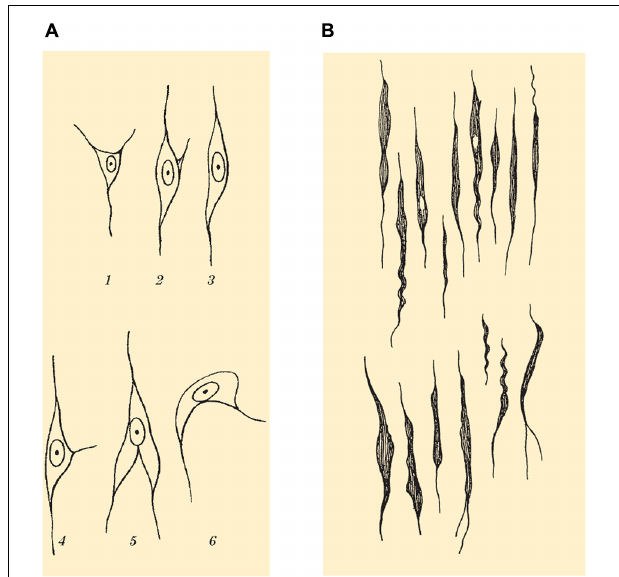
FIGURE 4 | (A) Drawing showing spindle cells ( Spindelzellen ) of layer VI and morphological variants as seen on Nissl staining. (B) Drawing showing VENs ( Stab- und Korkzieherzellen ) of layer Vb found in the FI and ACC as seen on Nissl staining. Images modified from von Economo and Koskinas (1925).